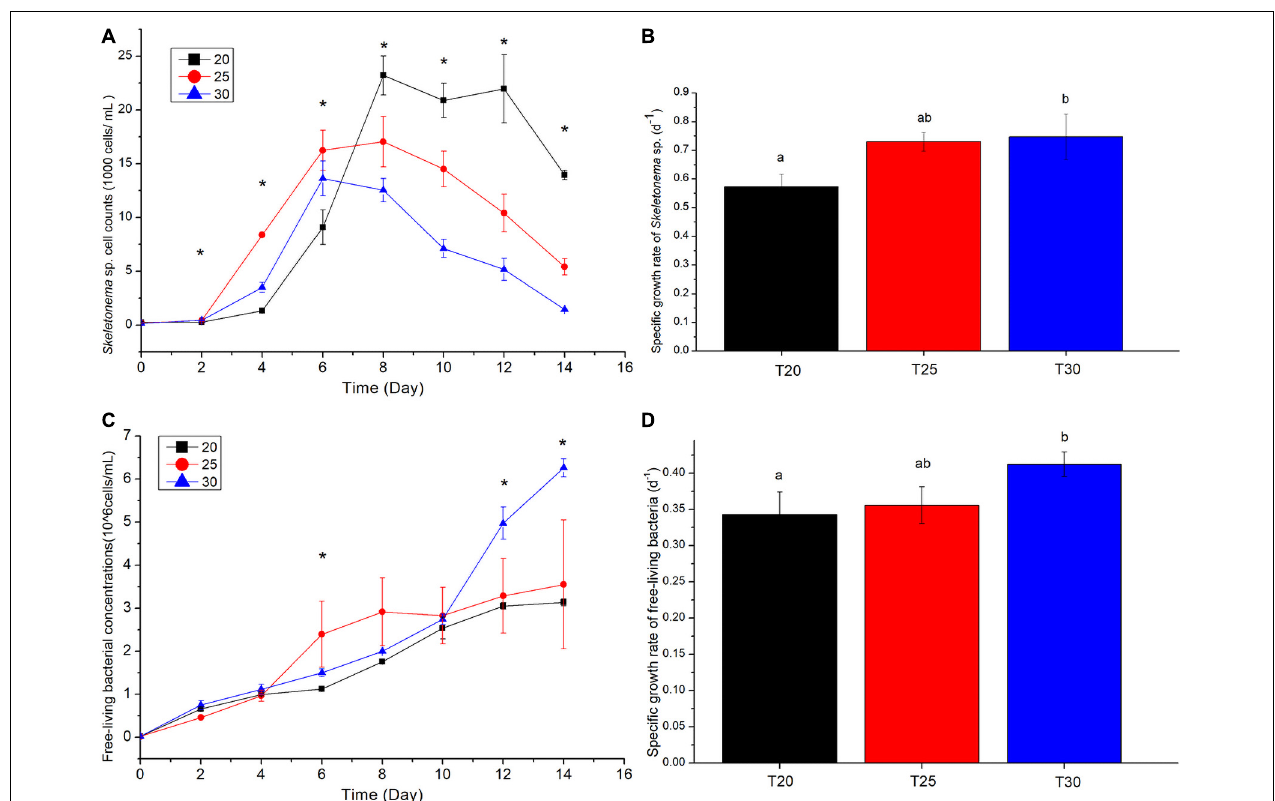
FIGURE 1 | (A) Growth curve and (B) specific growth rate of Skeletonema sp. at 20 (T20), 25 (T25), and 30 ◦ C (T30). The (C) growth curve and (D) specific growth rate of free-living bacteria in the culture at 20 (T20), 25 (T25), and 30 ◦ C (T30). *Indicates significant difference above all the three temperatures ( p < 0.05). Values are the means ± SD, n = 6 (six replicate cultures). Different letters indicate significant difference between different